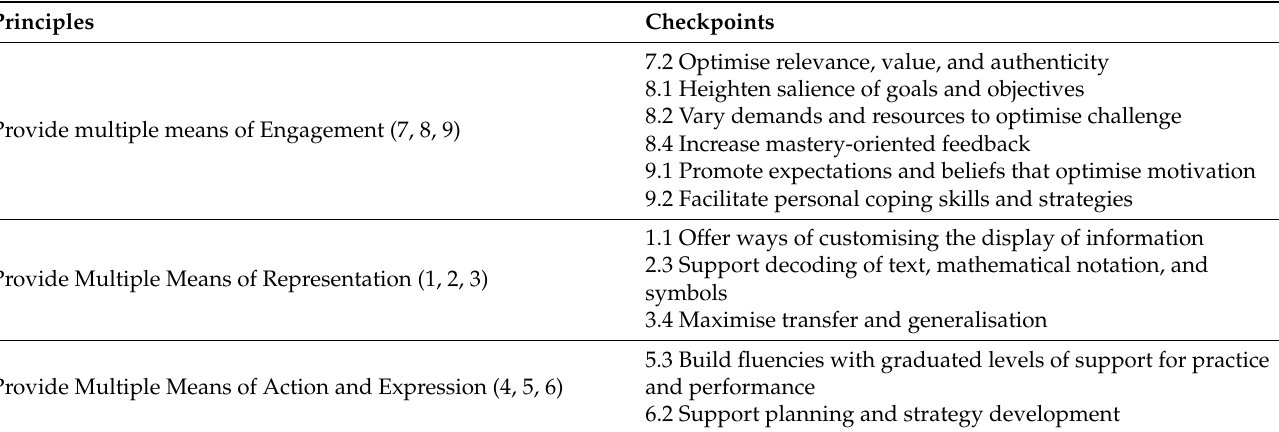
Table 4. Checkpoints identified as difficult to evaluate by